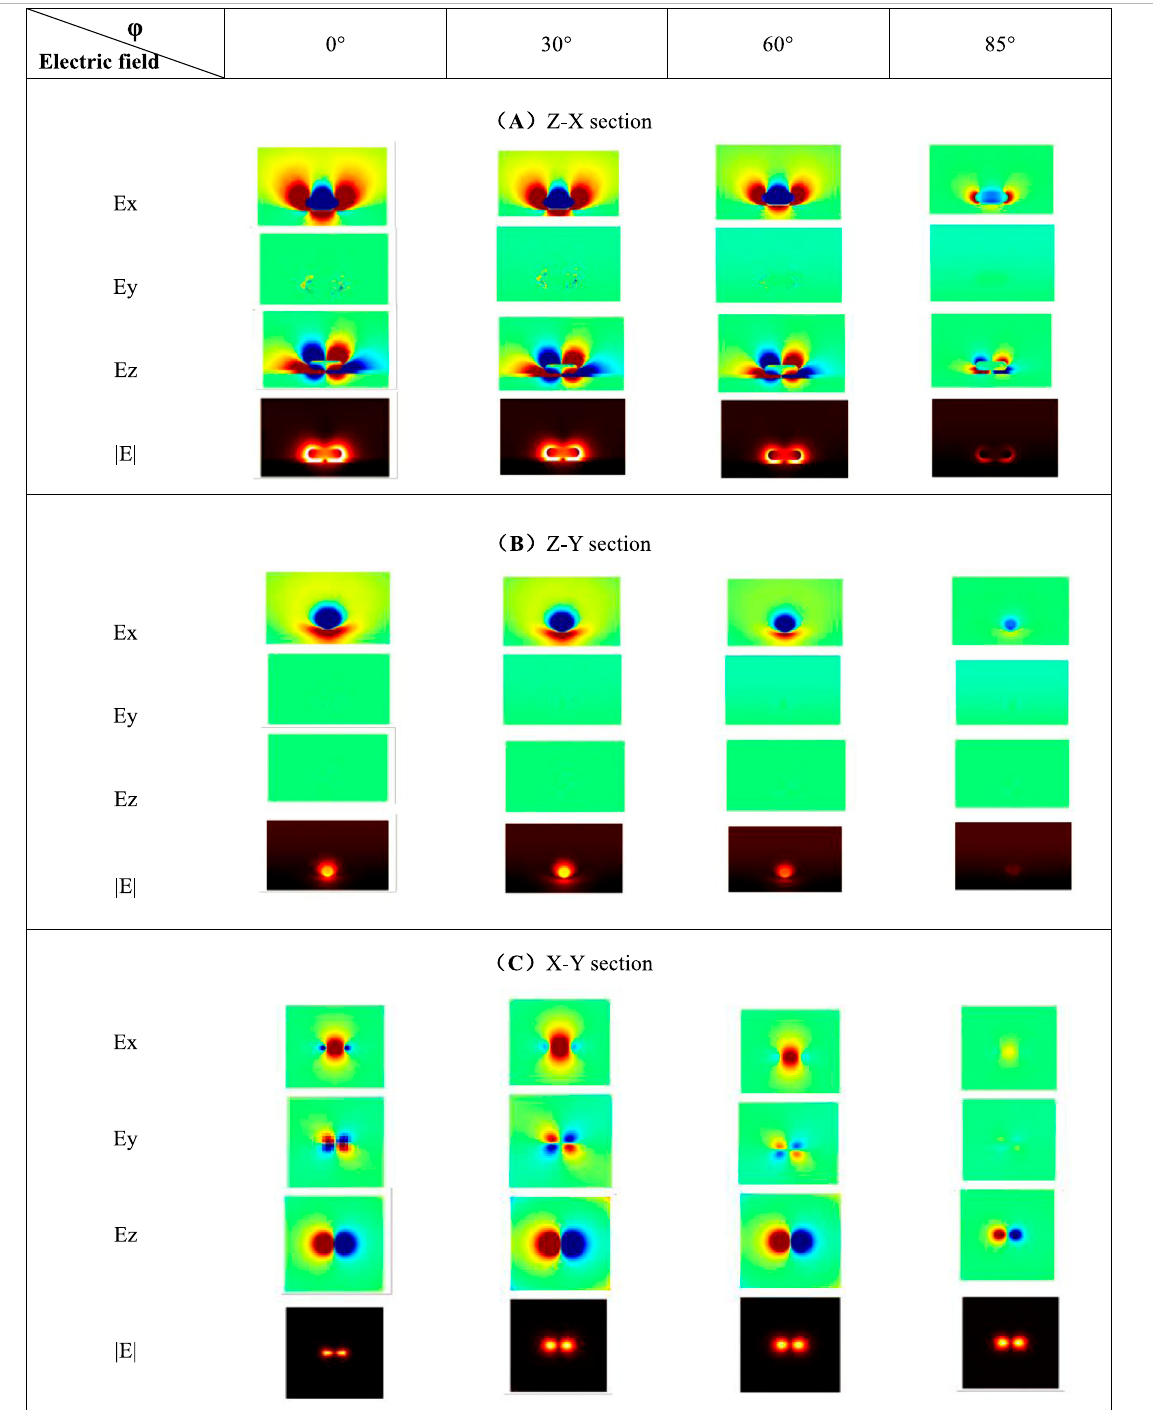
TABLE 3 | Cross-section diagrams of electric fi eld under different azimuth angles.